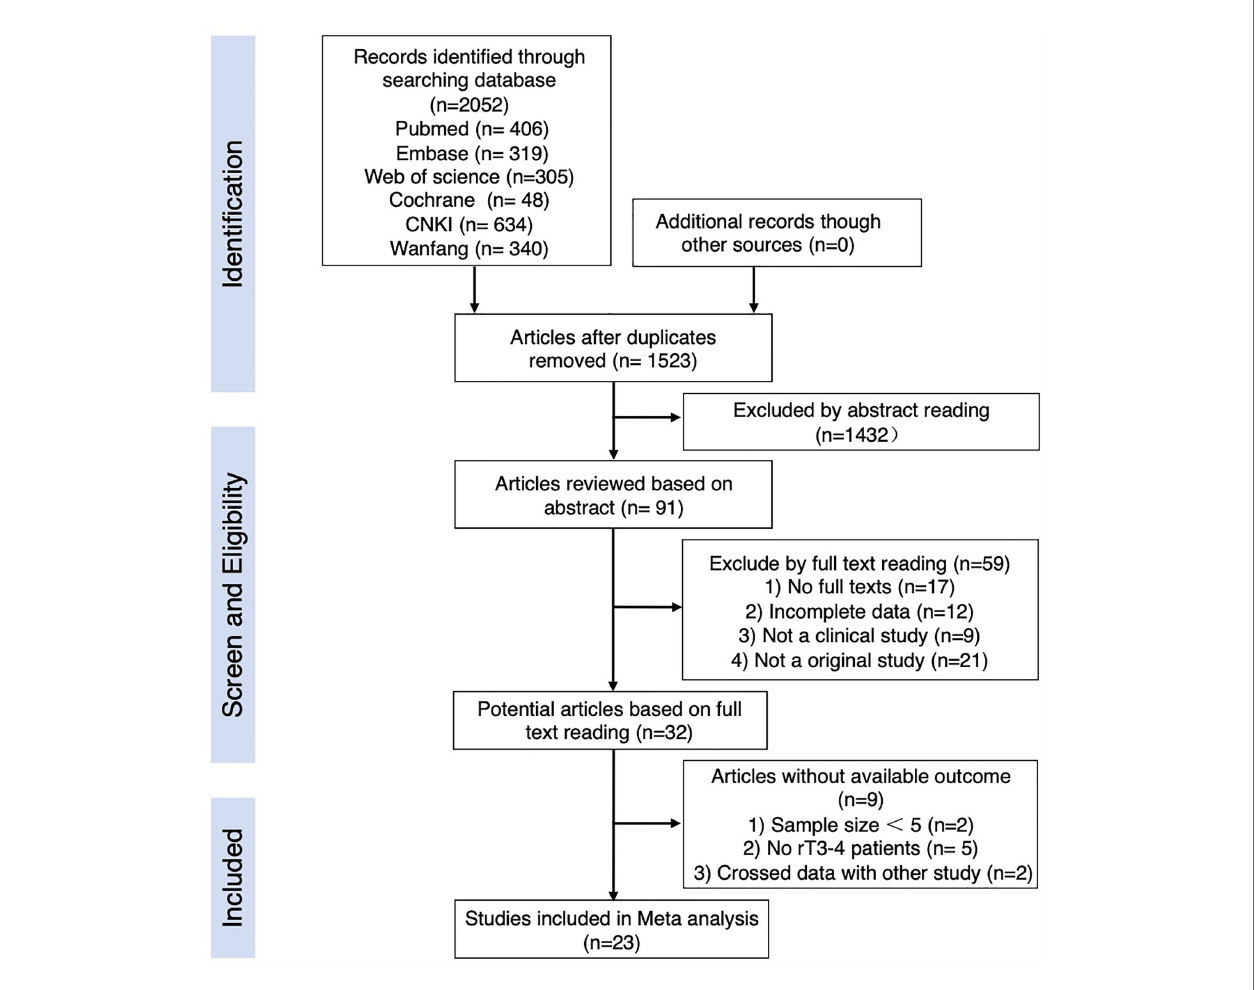
FIGURE 1 | Flowchart of the process of trial selection.